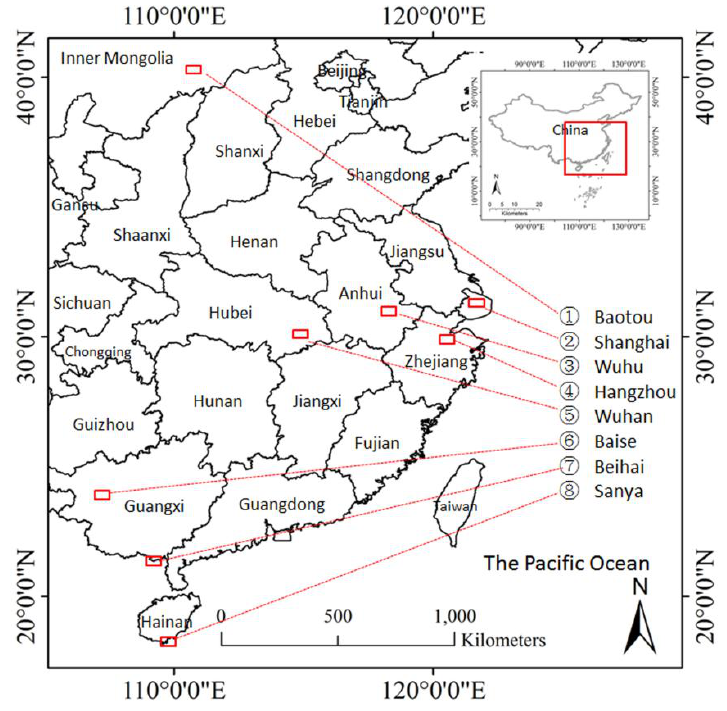
Figure 1. The distribution of ZY-3 NAD data used in this study.